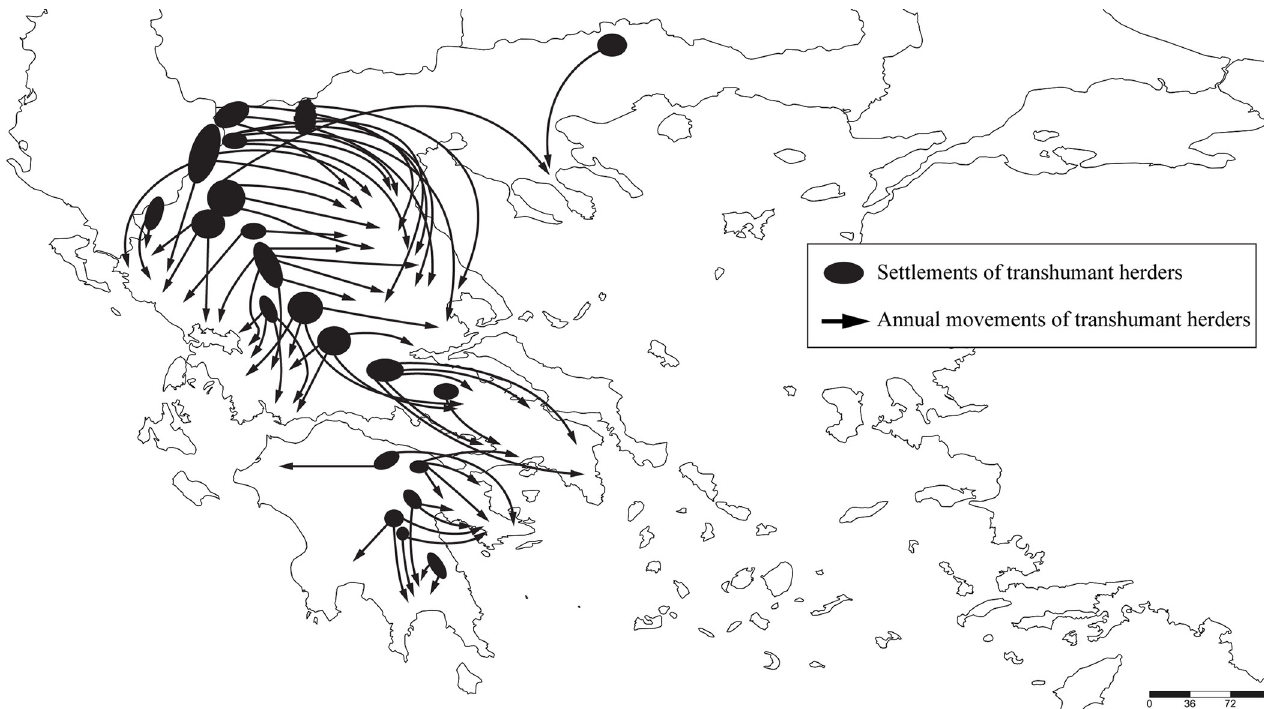
Fig 12. Representation of the annual movements of the transhumant herders of Greece (regardless of ethnicity or language) in 1981. The map was based on [90]. Movements of transitional breeders from Eastern and Central Macedonia and Thrace are not depicted, as their annual journeys greatly diminished or disappeared in those areas following the creation of the northern border of Greece in 1913–1920, the settlement of the exchanged Greeks of Asia Minor and Thrace (1923–1926), and the emigration of many Vlachs to Romania (1926 onwards) [42, 91].